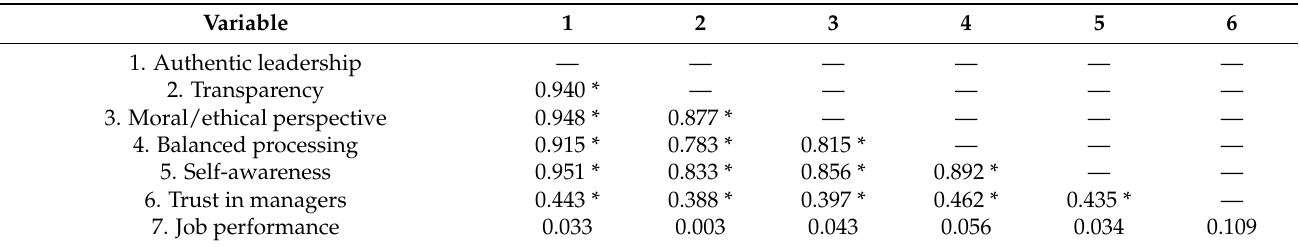
Table 4. Correlation matrix of study